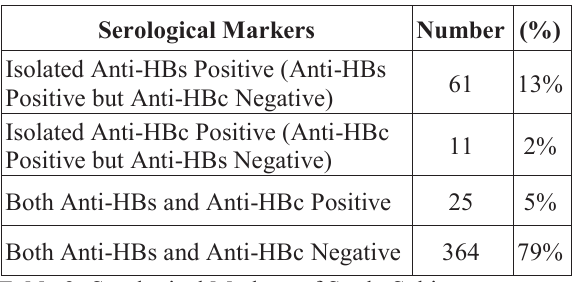
Table 3: Serological Markers of Study Subjects